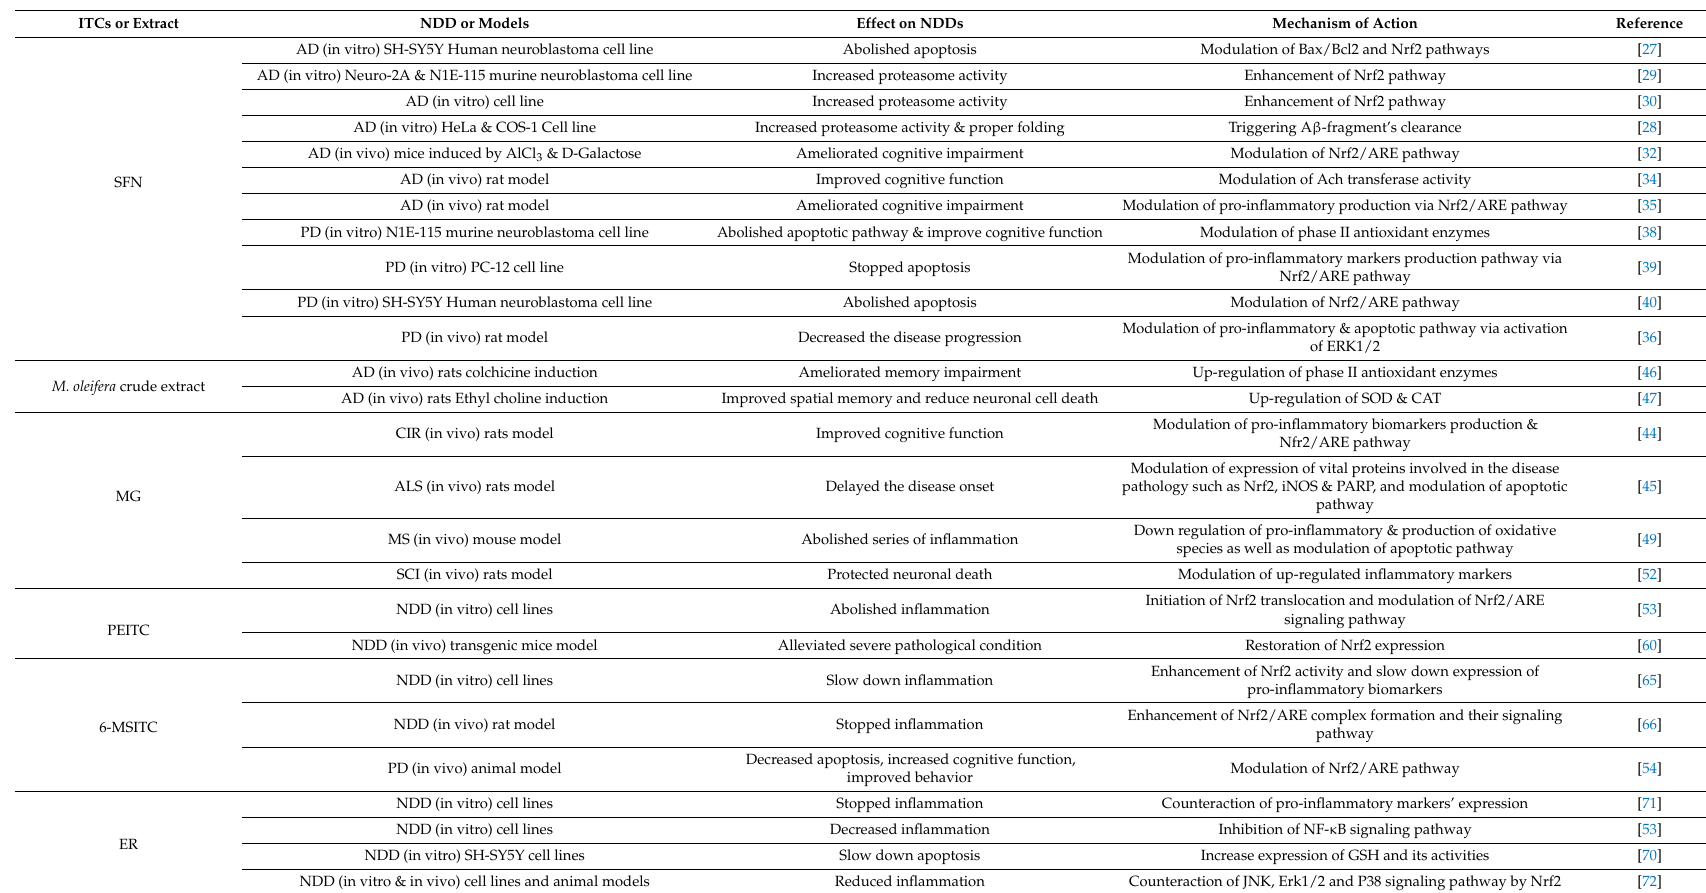
NDD represents neurodegenerative diseases; AD, Alzheimer’s disease; PD, Parkinson’s disease; ALS, Amyotrophic lateral sclerosis; MS, Multiple sclerosis; SCI, Spinal cord injury; CIR, Cerebral ischemia/reperfusion; ITCs, Isothiocyanates; SOD, Superoxide dismutase; CAT, catalase; iNOS, inducible nitric oxide synthase; PARP, poly ADP ribose polymerase. NB: severe inflammation lead to up-regulation of cytokines and other pro-inflammatory markers which result in neurodegenerative diseases if not arrested at early